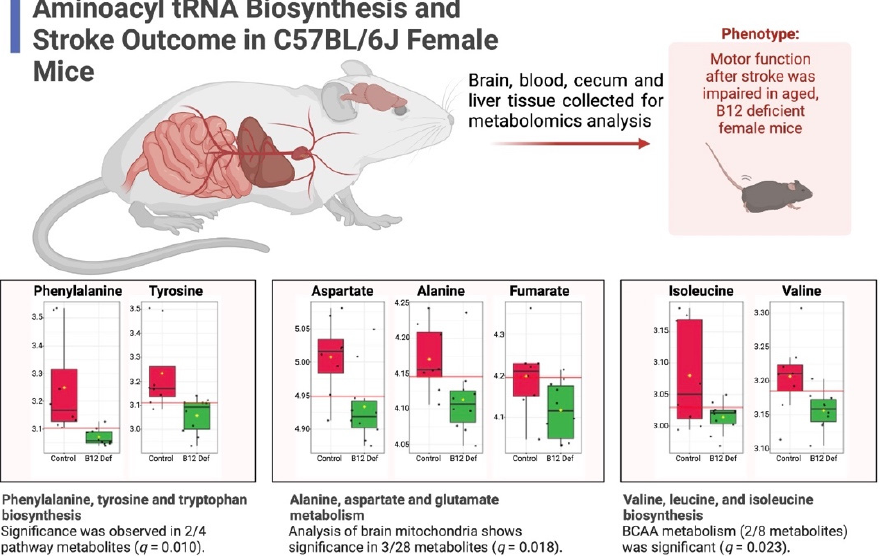
Figure 5. Pathway analysis results summarized in the context of aminoacyl tRNA biosynthesis. Metabolomic analysis (scatter plots) of brain mitochondria suggests involvement of phenylalanine, tyrosine, and tryptophan biosynthesis, alanine, aspartate and glutamate metabolism, and valine, leucine, and isoleucine biosynthesis in impaired motor function following stroke (all metabolites p < 0.05). Predicted functional significance ( q ) adjusted for FDR. BCAA, branched-chain amino acids.